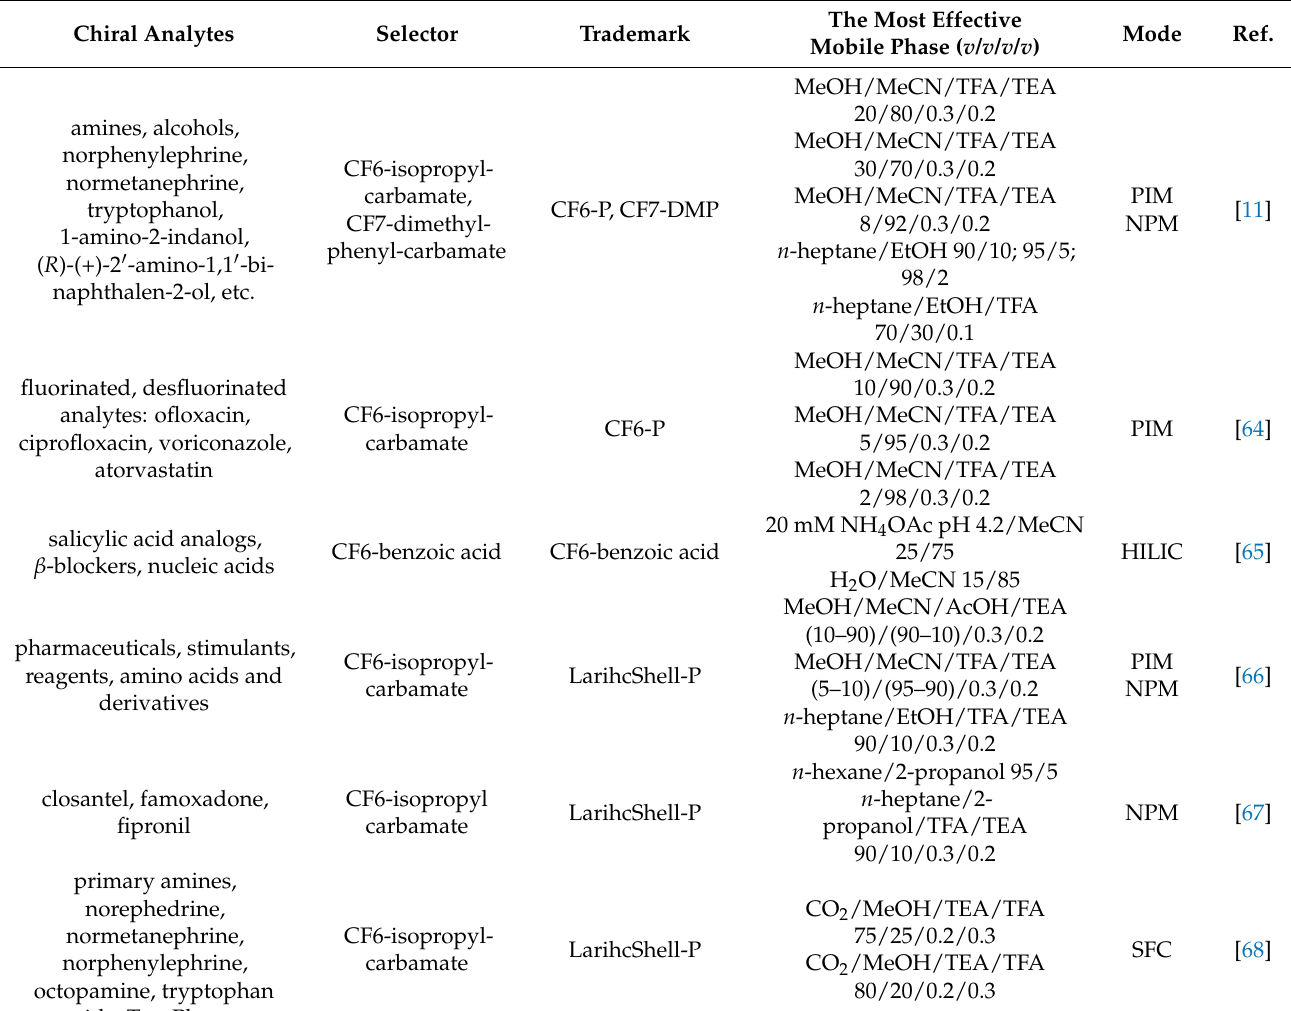
Table 4. Ultra-high-performance liquid chromatographic enantioseparations on derivatized cyclofructan analogs immobi- lized on 2.7 µ m superficially porous particles 1